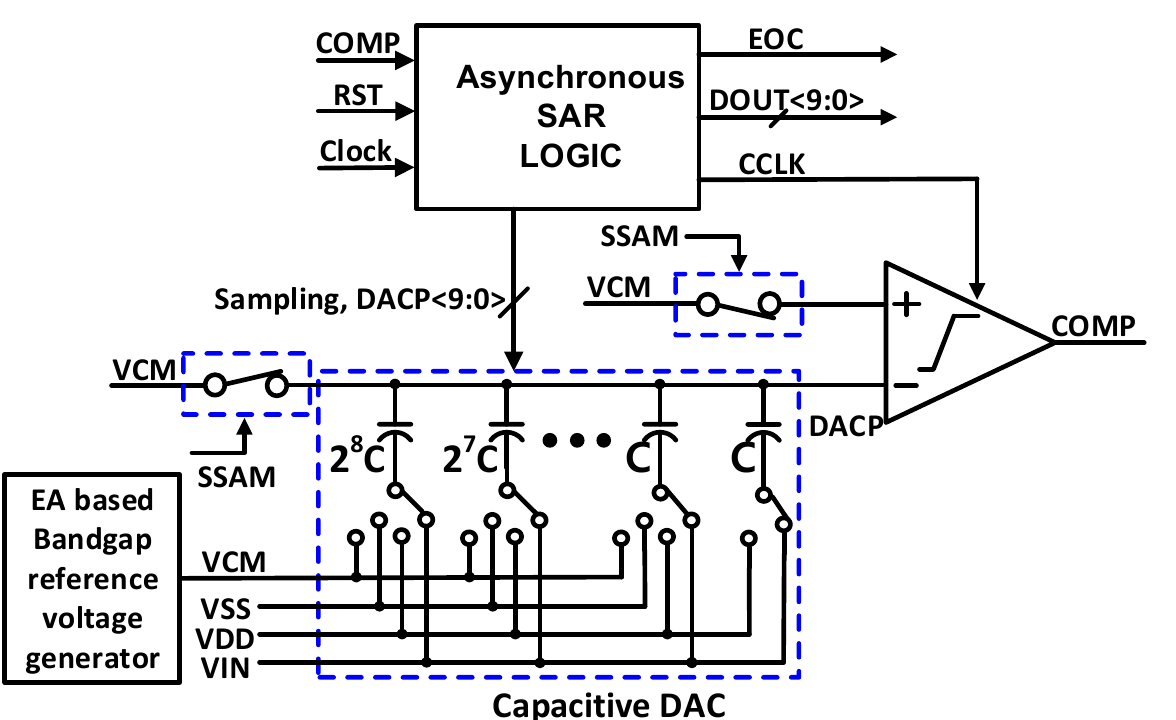
Figure 1. The proposed block diagram of the asynchronous SAR ADC with an EA-based bandgap reference voltage generator circuit.